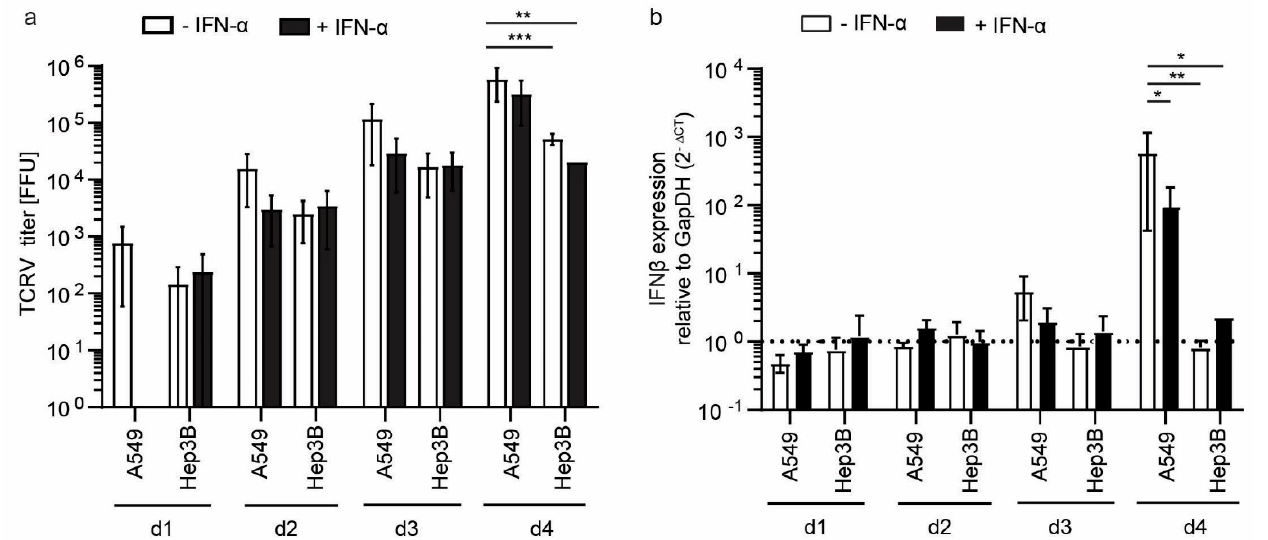
Figure 7. Susceptibility and IFN response of A549 and Hep3B cells to TCRV. Cells were mock-treated or pretreated with IFN- α for 24 h and subsequently infected with TCRV (MOI 0.01) for indicated time points ( a ). Viral titer was determined by titration on Vero cells and staining against the nucleoprotein. IFN- β mRNA expression was measured by qRT-PCR as described in Figure 1a ( b ). Results are given as a mean ± SEM of three independent experiments (with technical duplicates). Two-way ANOVA, followed by Turkeys’s multiple comparison test * p < 0.05, ** p < 0.01, *** p < 0.001.